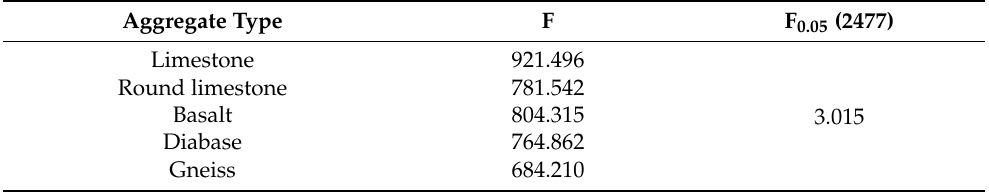
Table 3. Influence of particle size on aggregate texture factor.